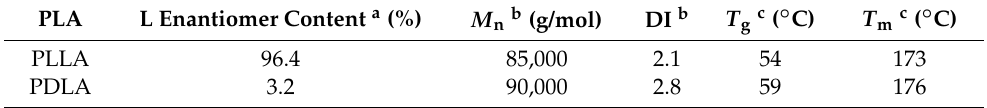
Table 1. Characteristics of poly( L -lactide) (PLLA) and poly( D -lactide) (PDLA). PLA L Enantiomer Content a